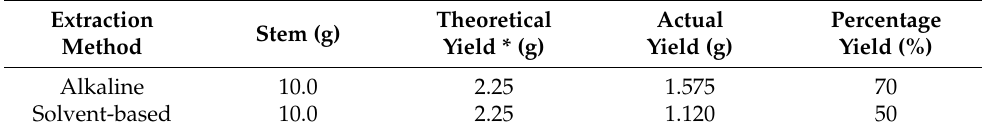
Table 1. Lignin extraction methodologies and